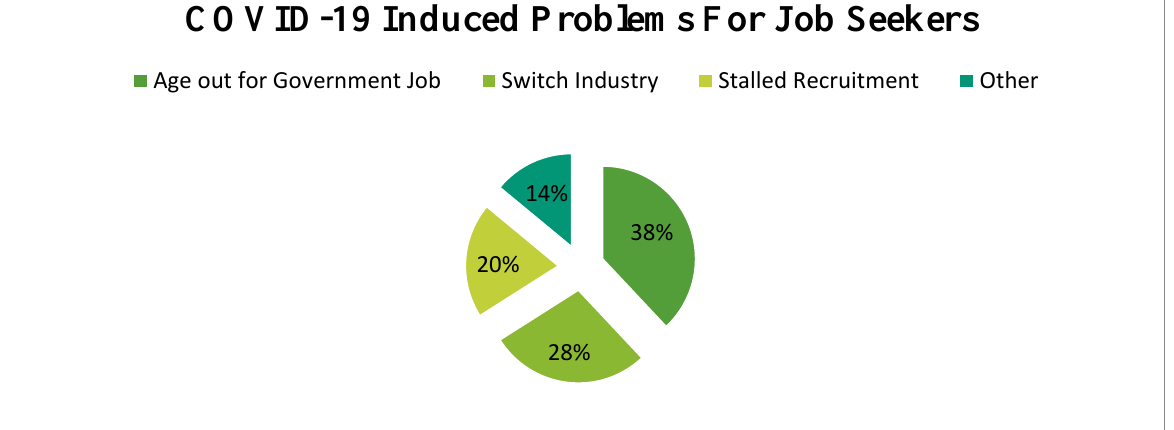
Figure 6: Figure 6 shows that among the 50 respondents, only 2 respondents shows normal symptoms by scoring below 44 in Zung Depression scale, and 9 job seekers shows symptoms of mild depression (scoring 45-59), the degree of depression reach on the moderate scale by 17 job seekers who experience moderate depressions, and 23 respondents shows symptom of severely depressed by scoring above 70+. Among the 50 respondents, 40